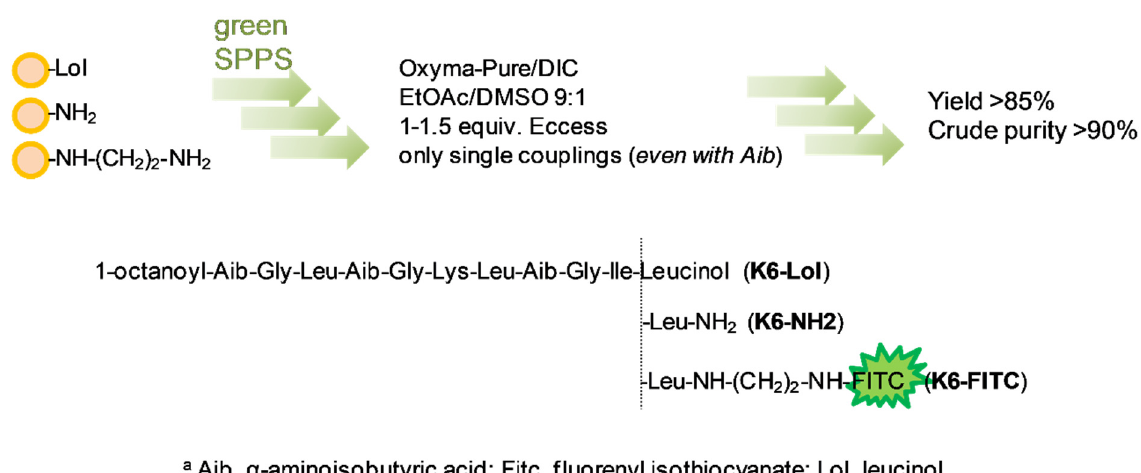
Scheme 1. Synthesis and chemical structure of K6-Lol, K6-NH2 and K6-FITC a .